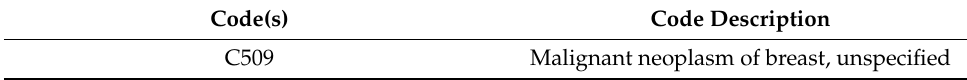
Table A1. Death record code indicating death from a second breast cancer event.